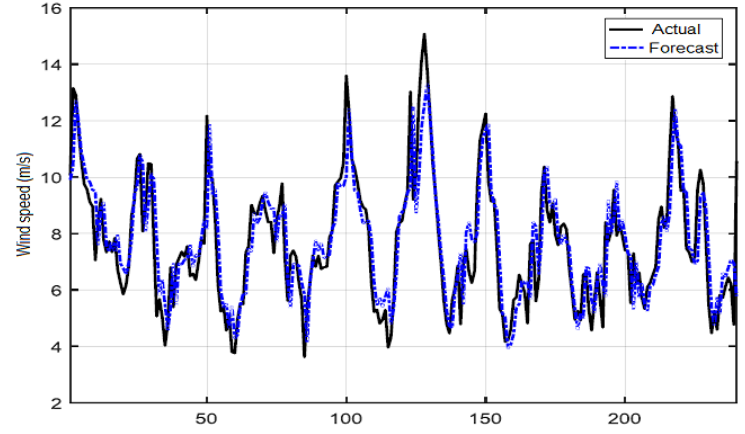
Figure 6. Sample of forecasts for TRI. Adapted from Gouveia [16]. Table 10. Main characteristics of the best ESN-AS.